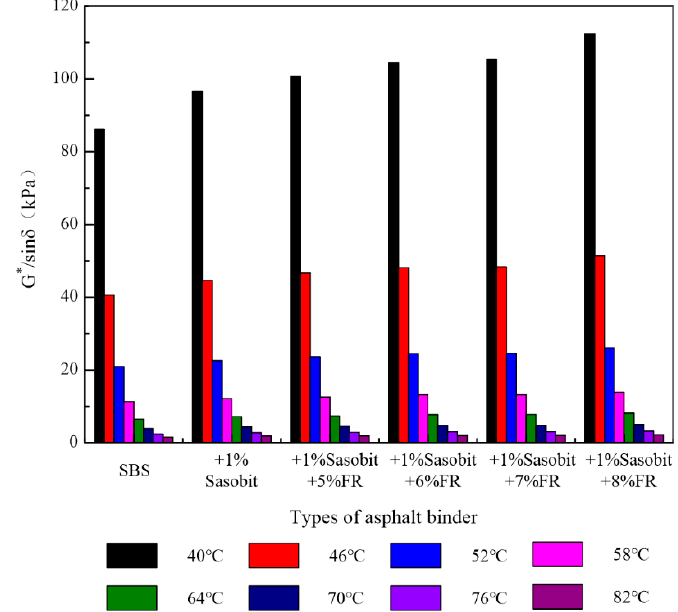
Figure 3. Results of the dynamic shear rheological test of original asphalt binder.